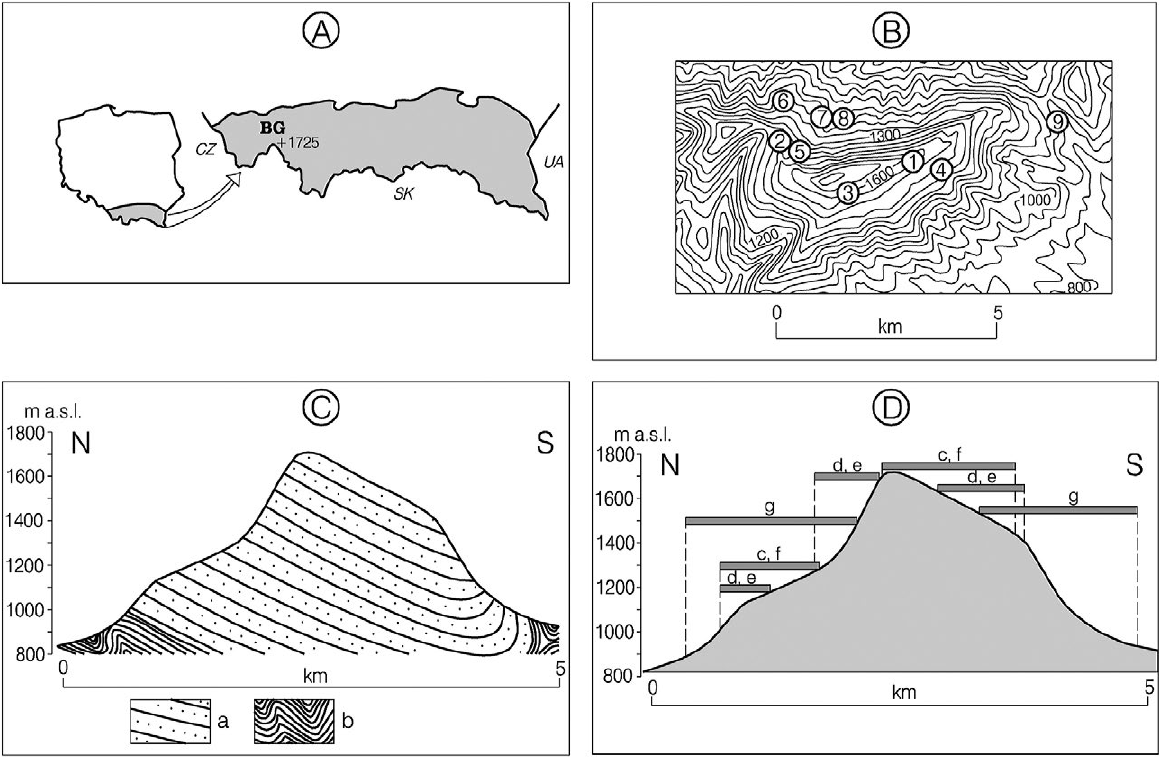
Fig. 1. Investigation area. A – location of Babia Góra massif. B – hypsometry of the massif and location of test areas (1–9). C – geological cross-section (N–S). D – height range of landslide forms at the northern and southern slopes of the massif. BG – Babia Góra massif, a – Magura sandstone, b – sub-Magura layers. Landslide forms: c – ridge and slope trenches, d – escarp- ments, headwalls and rocky walls, e – colluvial hummocks and hills, f – colluvial ramparts, g – colluvial tongues and